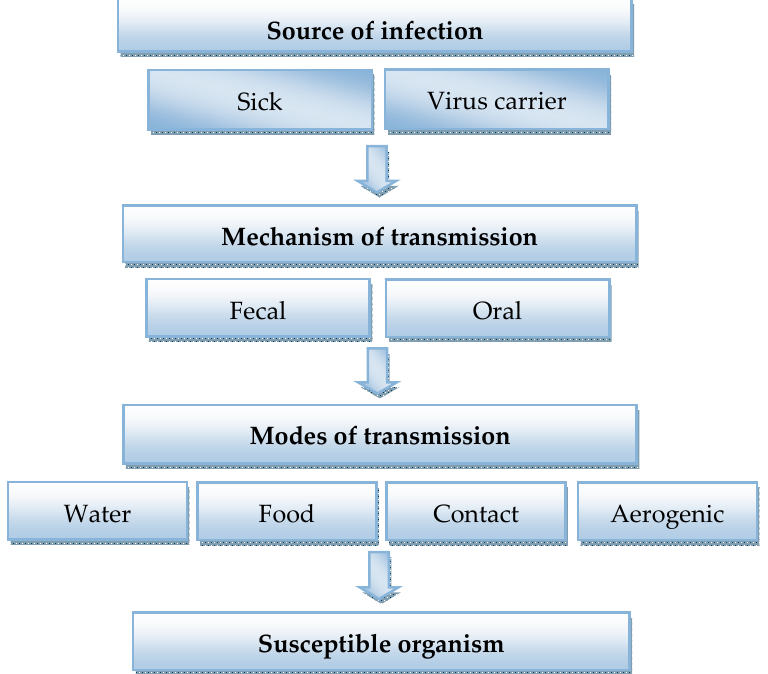
Figure 5. Epidemiology of coronavirus infection.